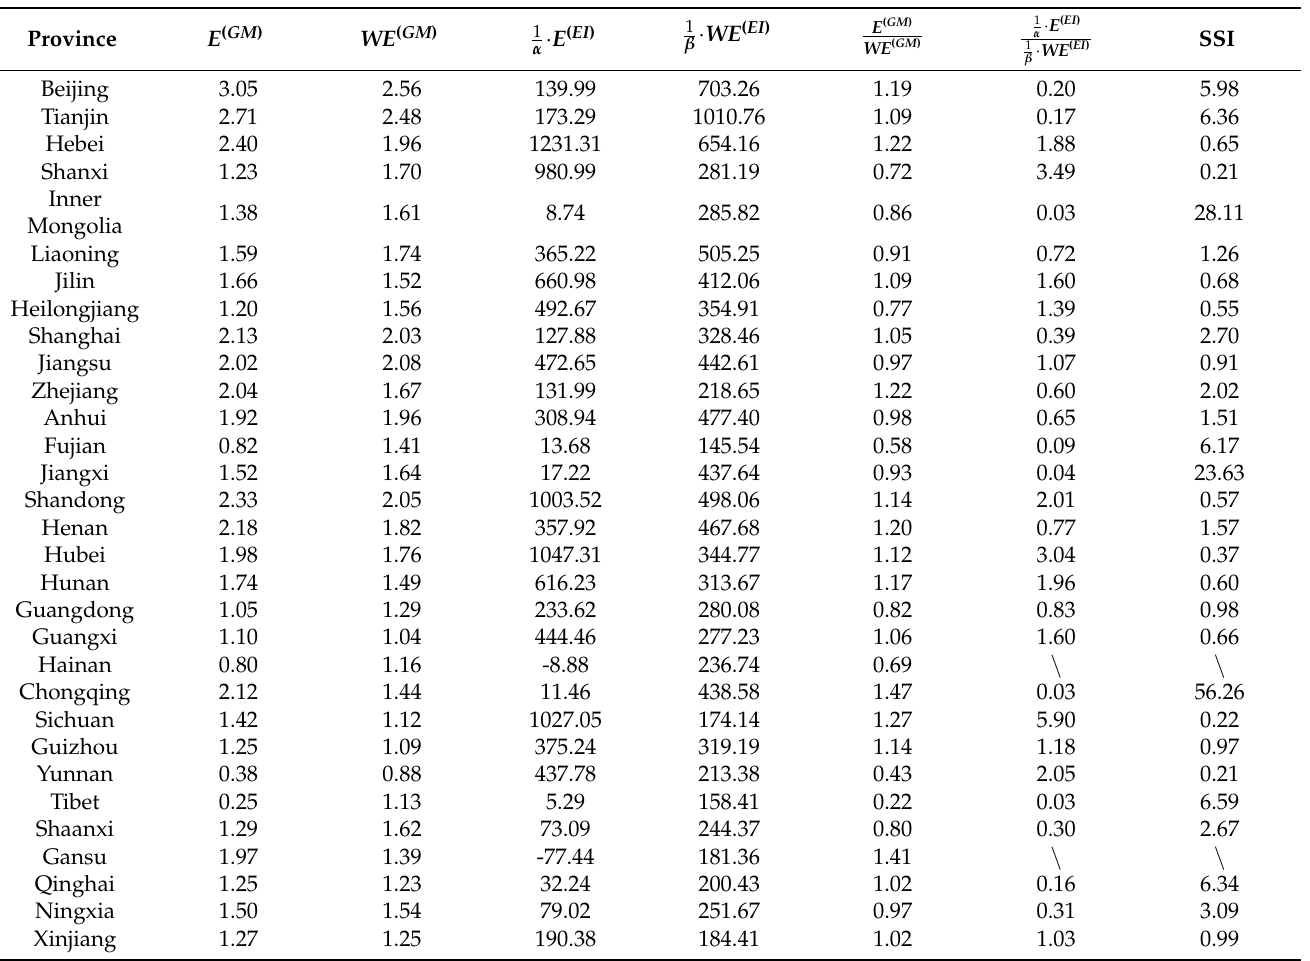
Table 2. Spatial spillover index values of the abatement effects of the Environmental Protection Tax Law on PM 2.5 pollution in provincial Chinese